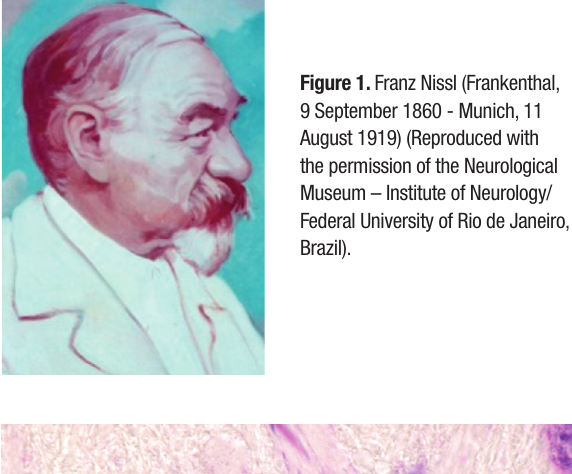
Figure 1. Franz Nissl (Frankenthal,